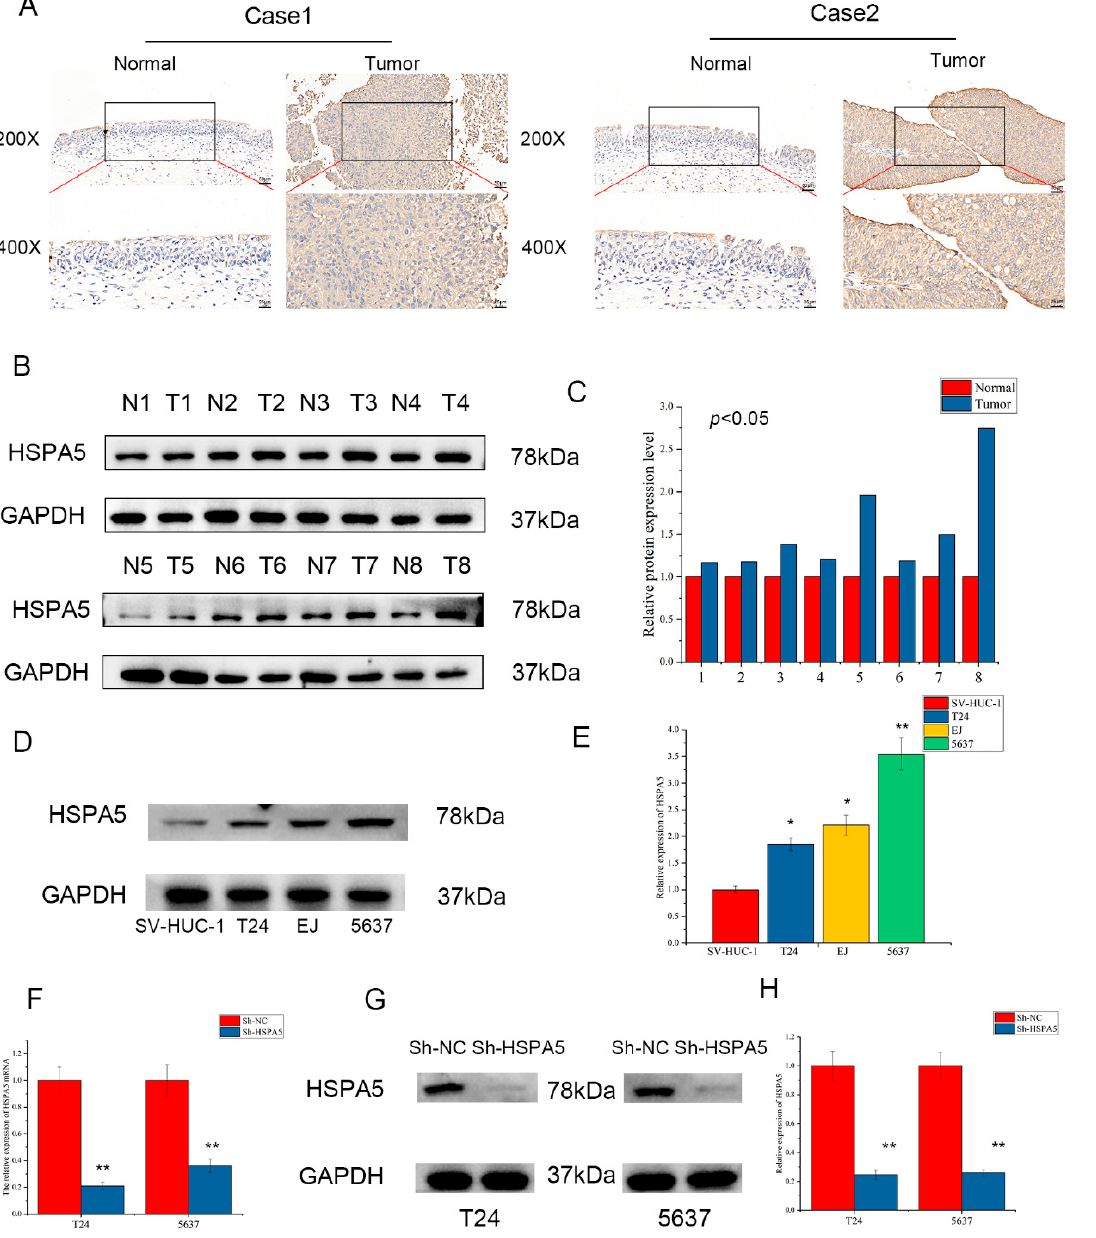
Figure 3. HSPA5 expression in clinical samples and cell lines. ( A ) Immunohistochemical staining observed at 200 × and 400 × showing the level of HSPA5 in BCa and adjacent tissues. ( B , C ) HSPA5 expression in BCa and adjacent samples. ( D , E ) The HSPA5 protein level in BCa cell lines and SV- HUC-A cells. ( F ) The expression of HSPA5 mRNA in the sh-HSPA5 groups compared with that in the control groups. ( G , H ) The effect of HSPA5 protein knockdown was determined. All data are presented as the mean ± SD. * p < 0.05, ** p < 0.01.